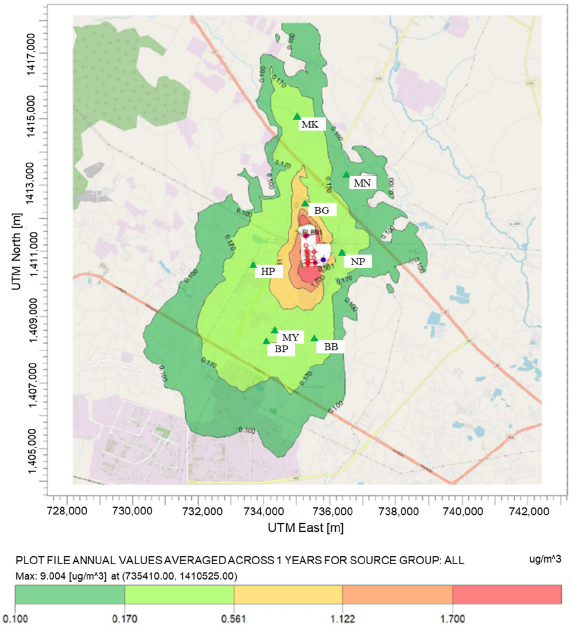
Figure 5. Spatial distribution of average annual benzene concentration.